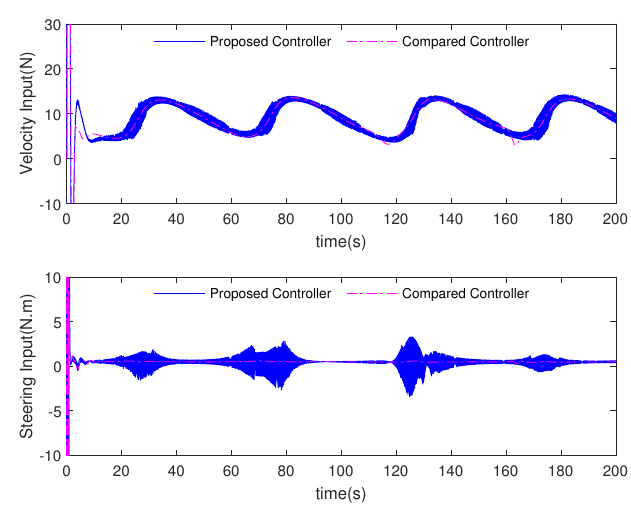
Figure 8. Control